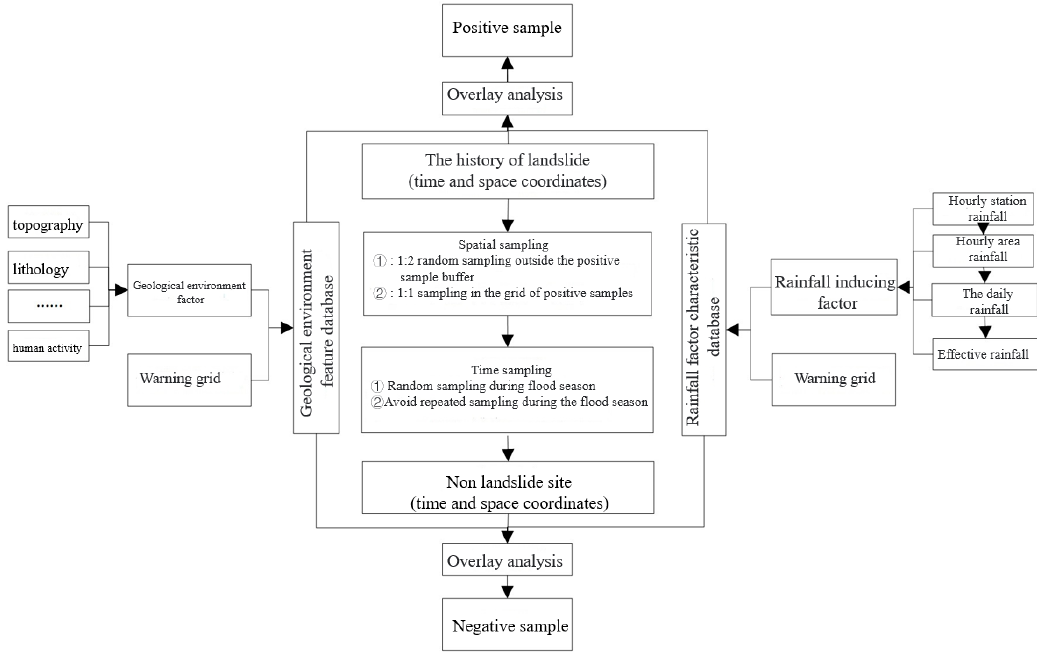
Figure 4. Training sample-set construction flowchart.